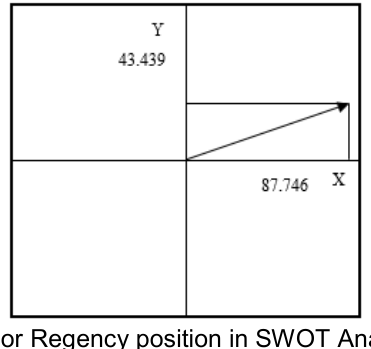
Figure 8. Alor Regency position in SWOT Analysis Chart (Source: Research Data,